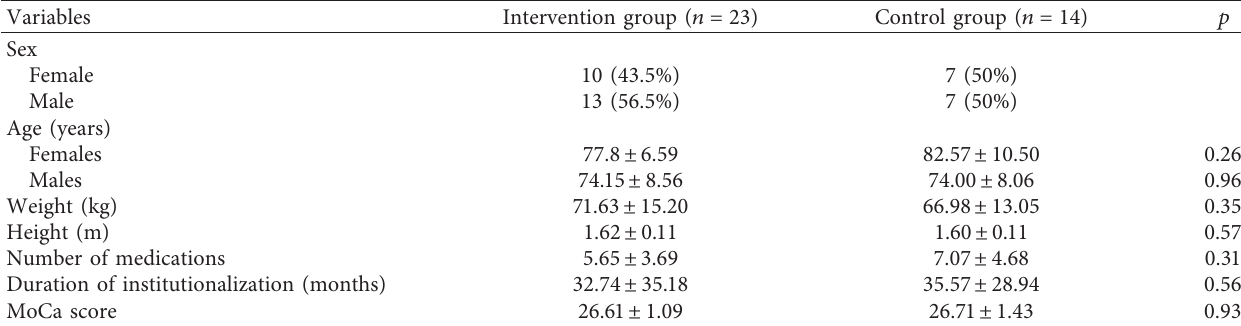
Table 1: Baseline demographic data of the participants and group comparisons (mean and SD).